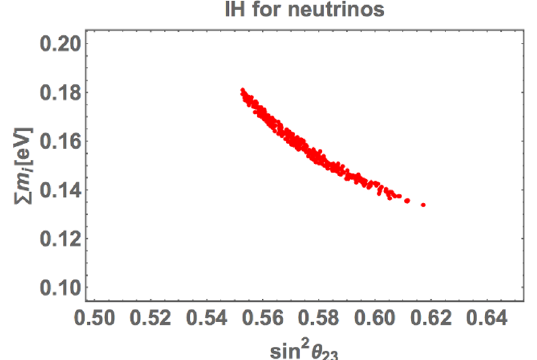
Figure 10 . The allowed region on sin 2 θ 23 – P m i plane for